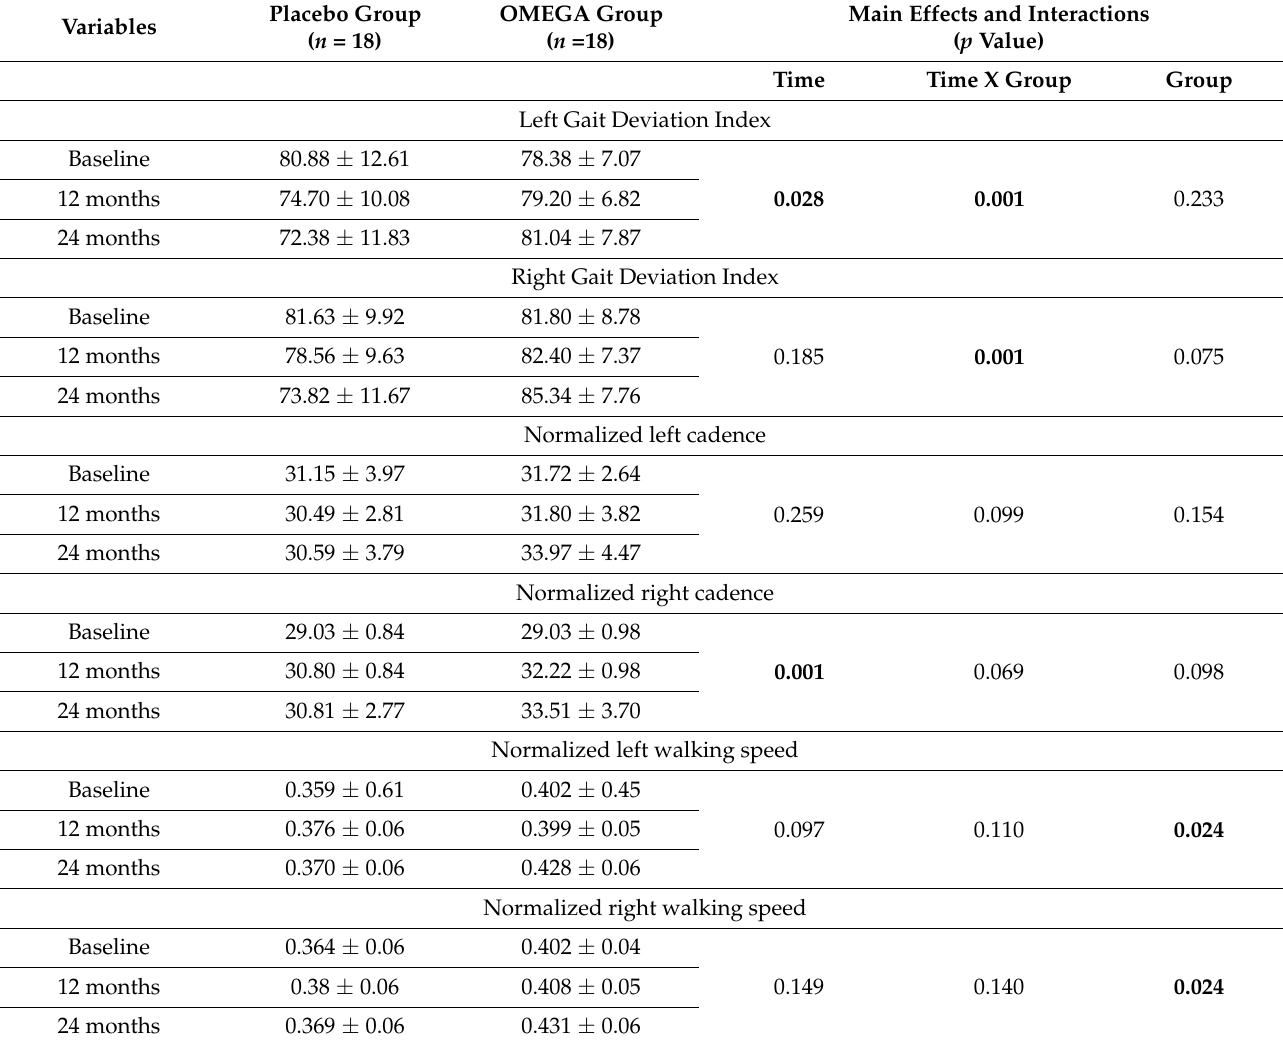
Table 3. Gait Deviation Index, cadence and walking speed data in both groups for all three time-points, excluding the dropouts.